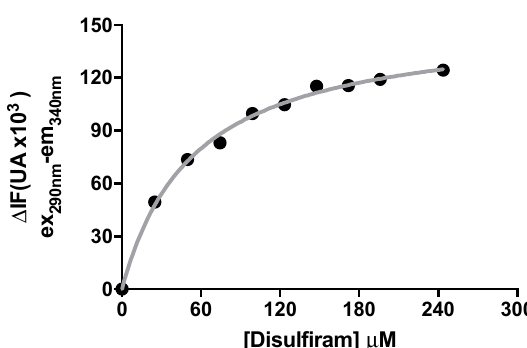
Figure 4. Binding of DSF to C. vulgaris urease at equilibrium. The change in the intrinsic fluorescence ( ∆ IF) was measured an hour after the addition of the indicated concentrations of DSF. A non-linear curve fit to Equation (5) was made and is indicated by the solid grey line. Curve data is obtained in one of three identical binding saturation experiments. Non-linear curve fitting and plots were prepared using Graph Pad Prism 5 ® .